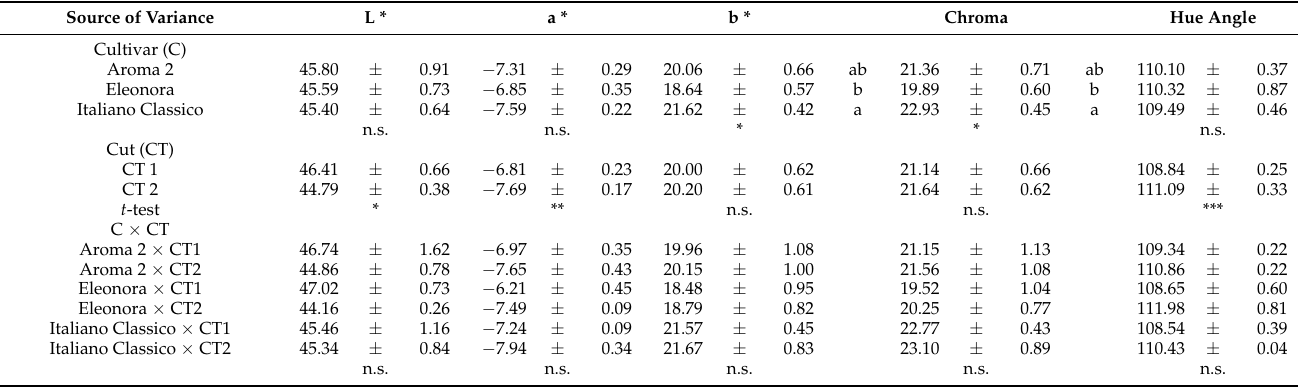
Table 1. Effect of cultivar and cut on CIELAB colorimetric coordinates, chroma, and hue angle of basil leaves. Source of Variance